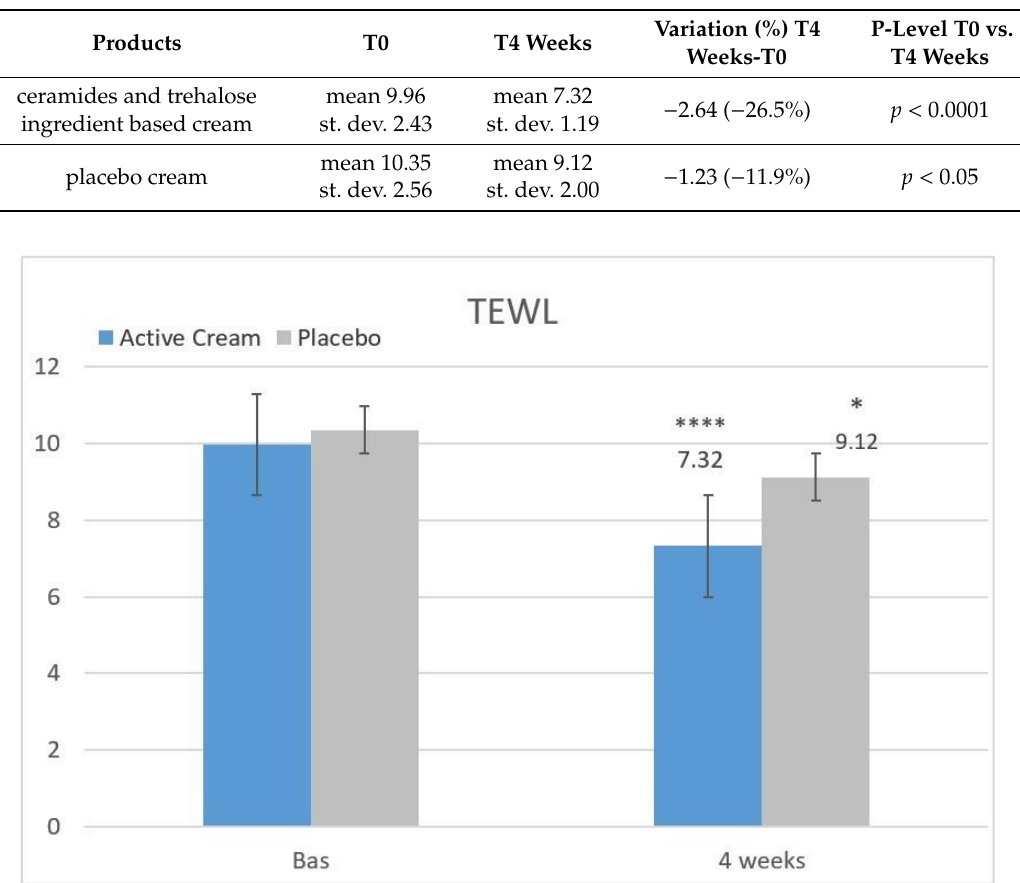
Figure 5. Figure 5. Mean values of transepidermal water loss recorded for cream containing trehalose